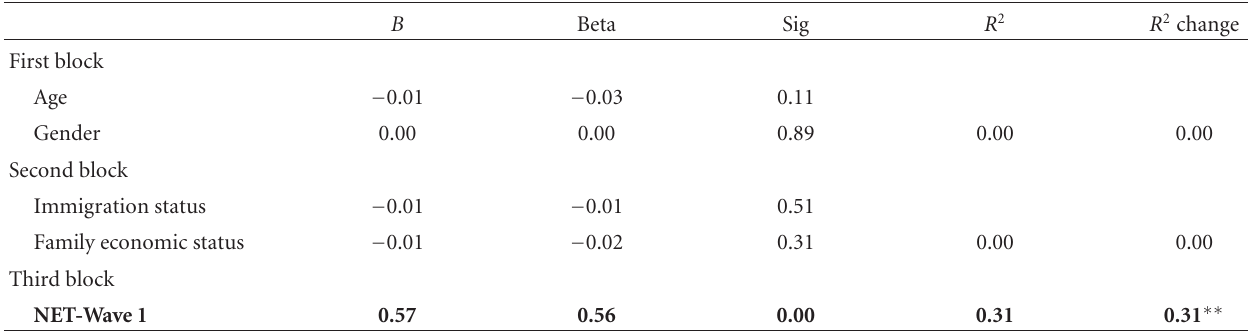
Table 3: Multiple regression analyses on students’ Internet use behavior.